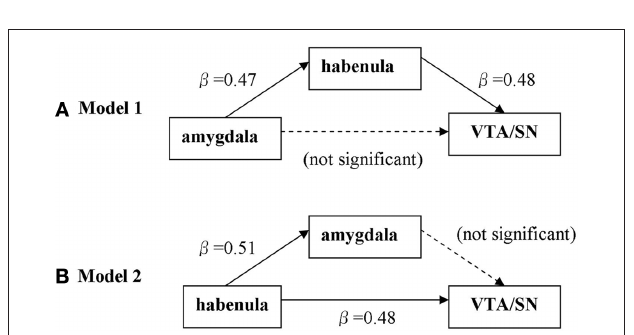
Figure 7 | Single-level mediation analysis of the error-related effect-size (Se > SS) across subjects. (A) Model to test whether habenula mediates the correlation between amygdala and VTA/SN. (B) Model to test whether amygdala mediates the correlation between habenula and VTA/SN.